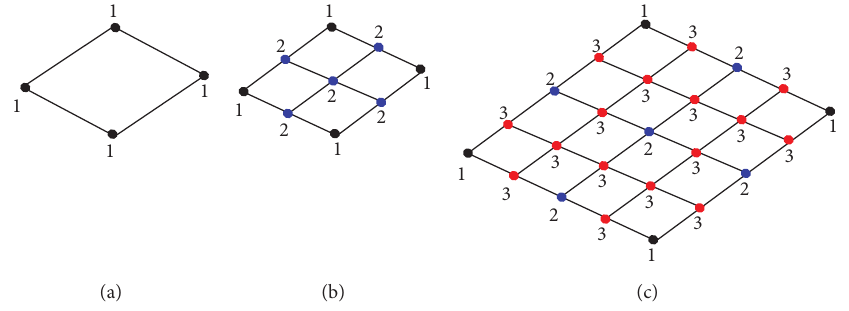
Figure 1: Illustration of the two-dimensional SRAM.